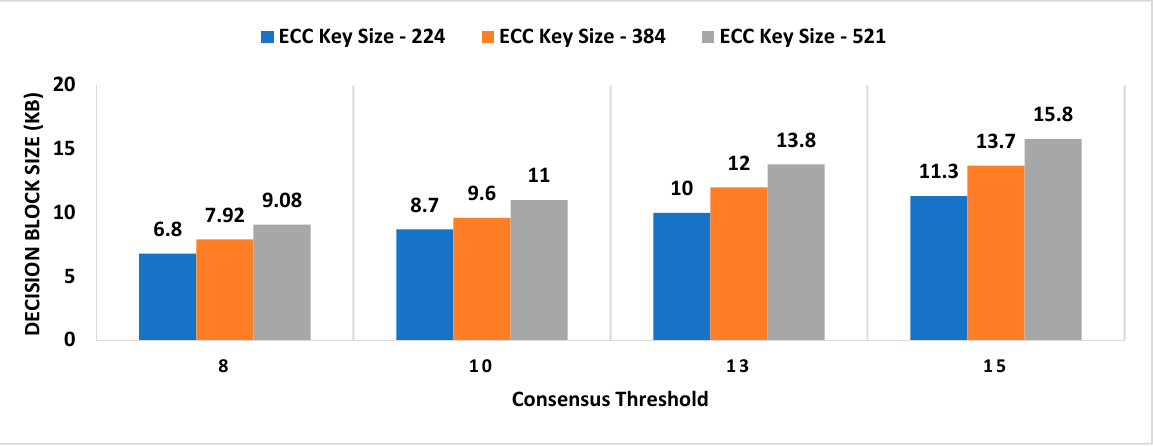
Figure 11. Consensus threshold and key size impact on decision block size.